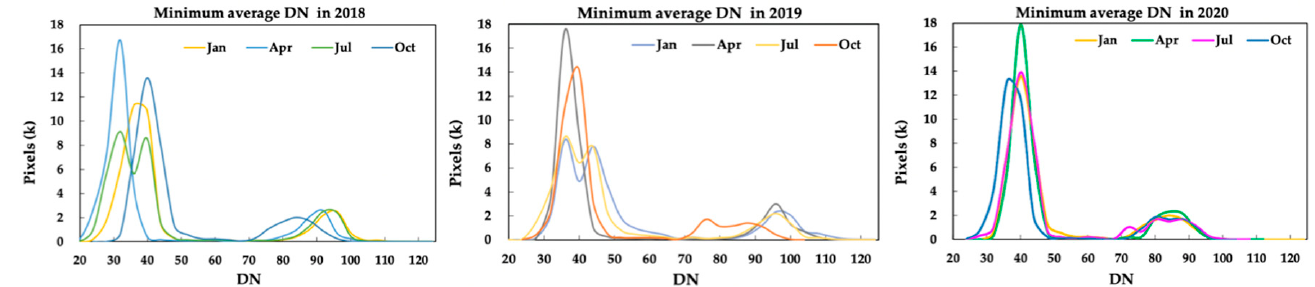
Figure 6. The DN-pixel transformation curve from the custom aerosol model for a particular value of τ as measured by the